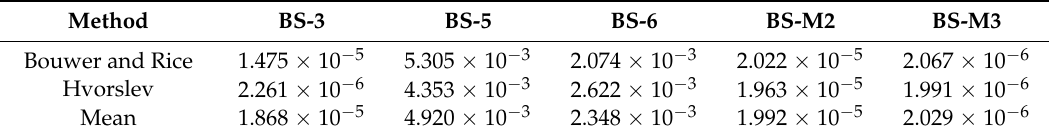
Table 9. The hydraulic conductivity values that were estimated using slug tests (unit: m/s).